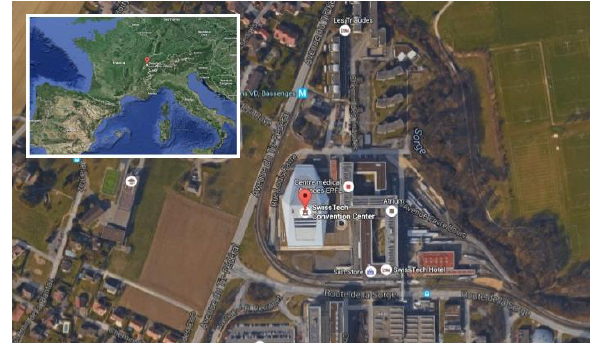
Figure 1. Location of the study